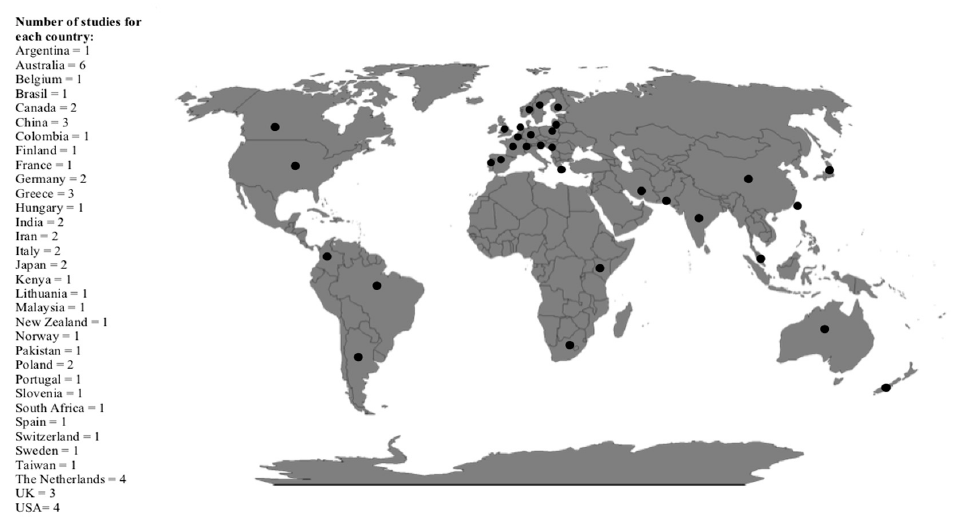
Figure 2. Countries’ distribution of the 39 selected studies.